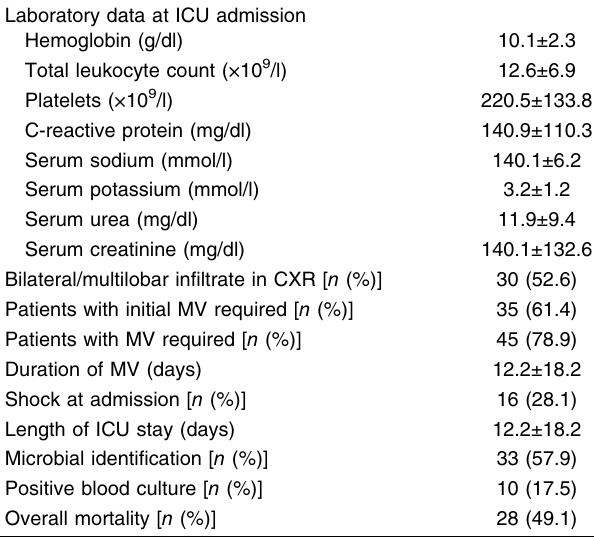
Table 2 Patient